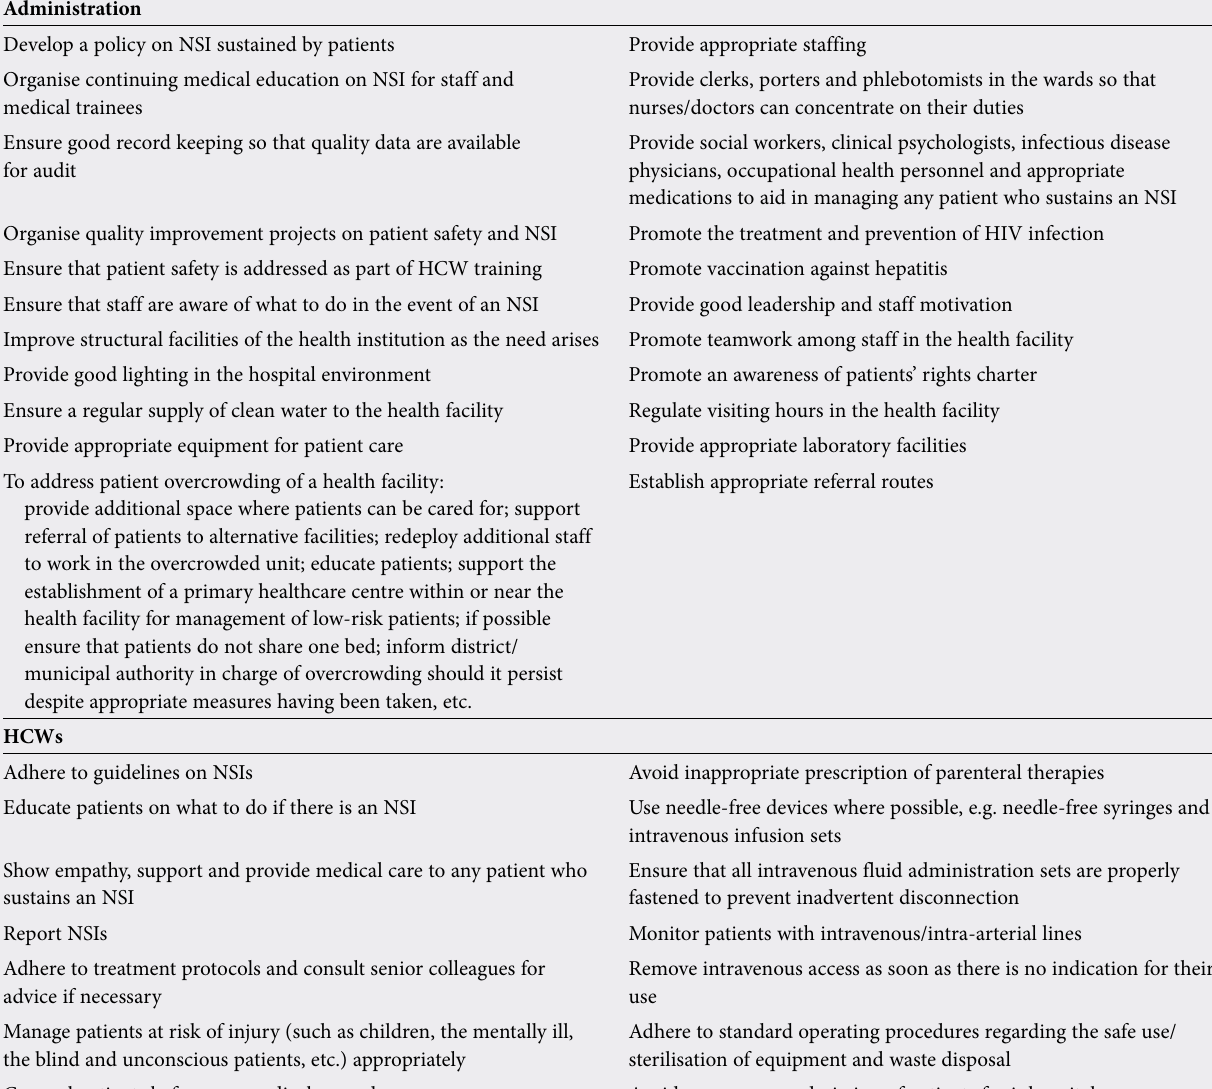
Table 1. Measures to prevent NSI in patients at different levels of the healthcare system